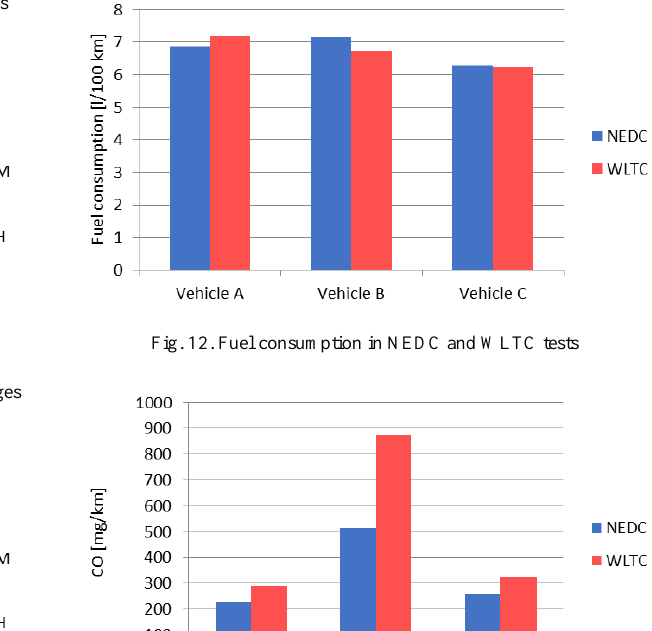
Fig. 9. Hydrocarbons emissions in WLTC test and its particular stages